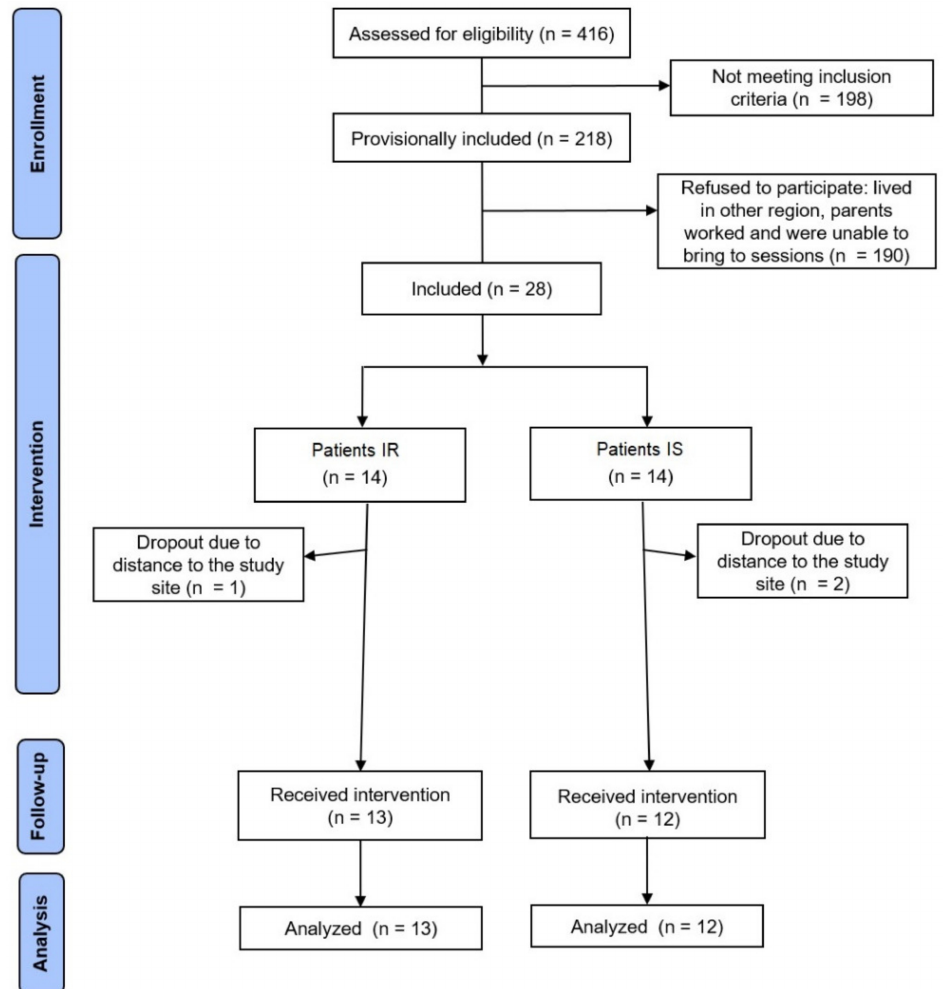
Figure 1. Flow chart depicting process of enrollment, allocation and follow-up of the 25 study participants. Groups insulin-resistant (IR) and insulin-sensitive